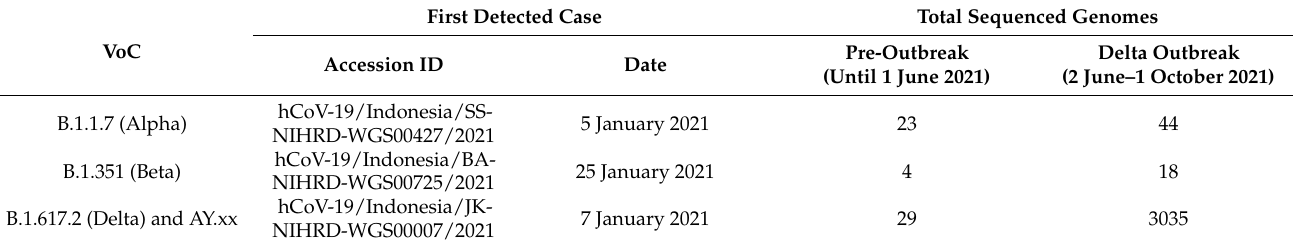
Table 2. VoCs before and during the Delta